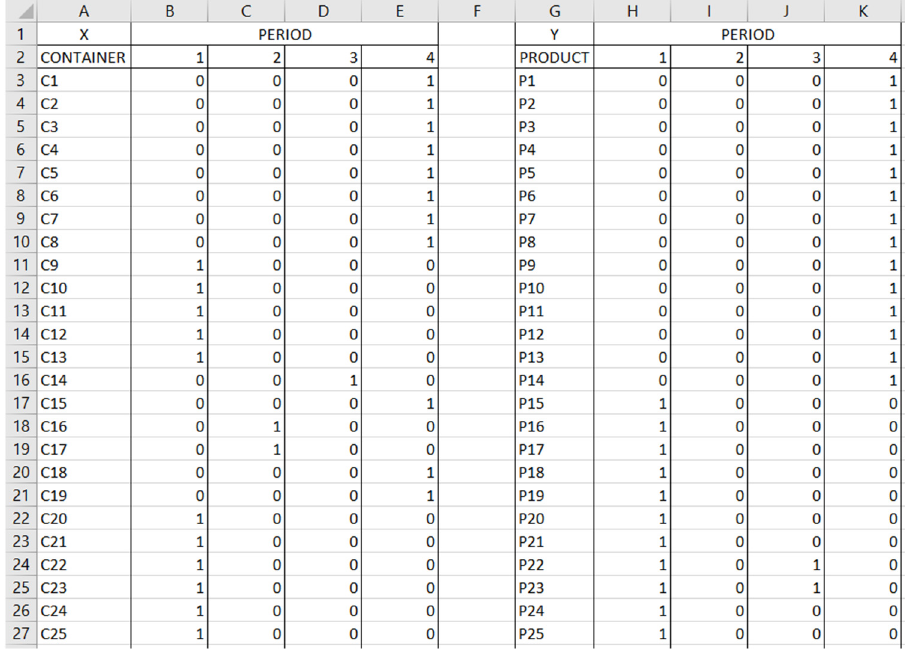
Figure 5. Output of decision variables x and y for Case 1 in the form of an Excel spreadsheet. Table 1. Summary of the decision variables for Case